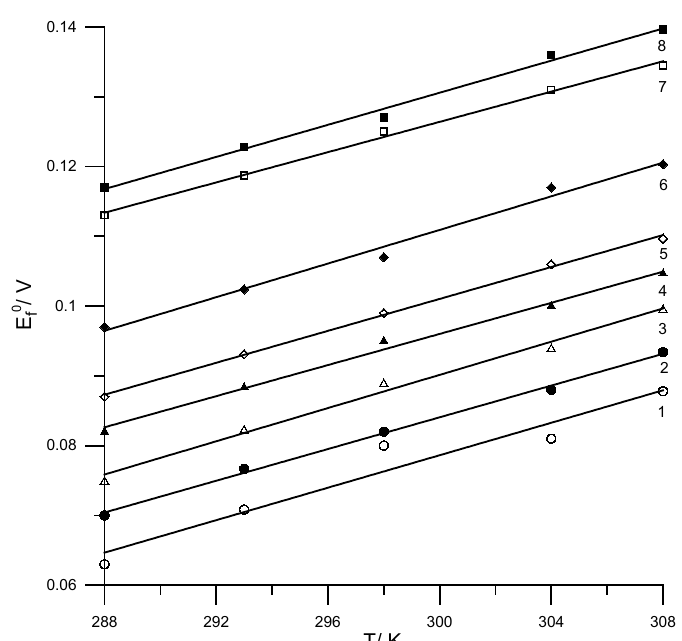
Figure 4. Temperature dependence of the formal potential of 1×10 -3 mol dm -3 Bi(III) electroreduction in 1–8 mol dm -3 chlorates (VII) in the presence 1×10 -3 mol dm -3 cystine. The concentration of chlorates (VII) in mol dm -3 is indicated at each